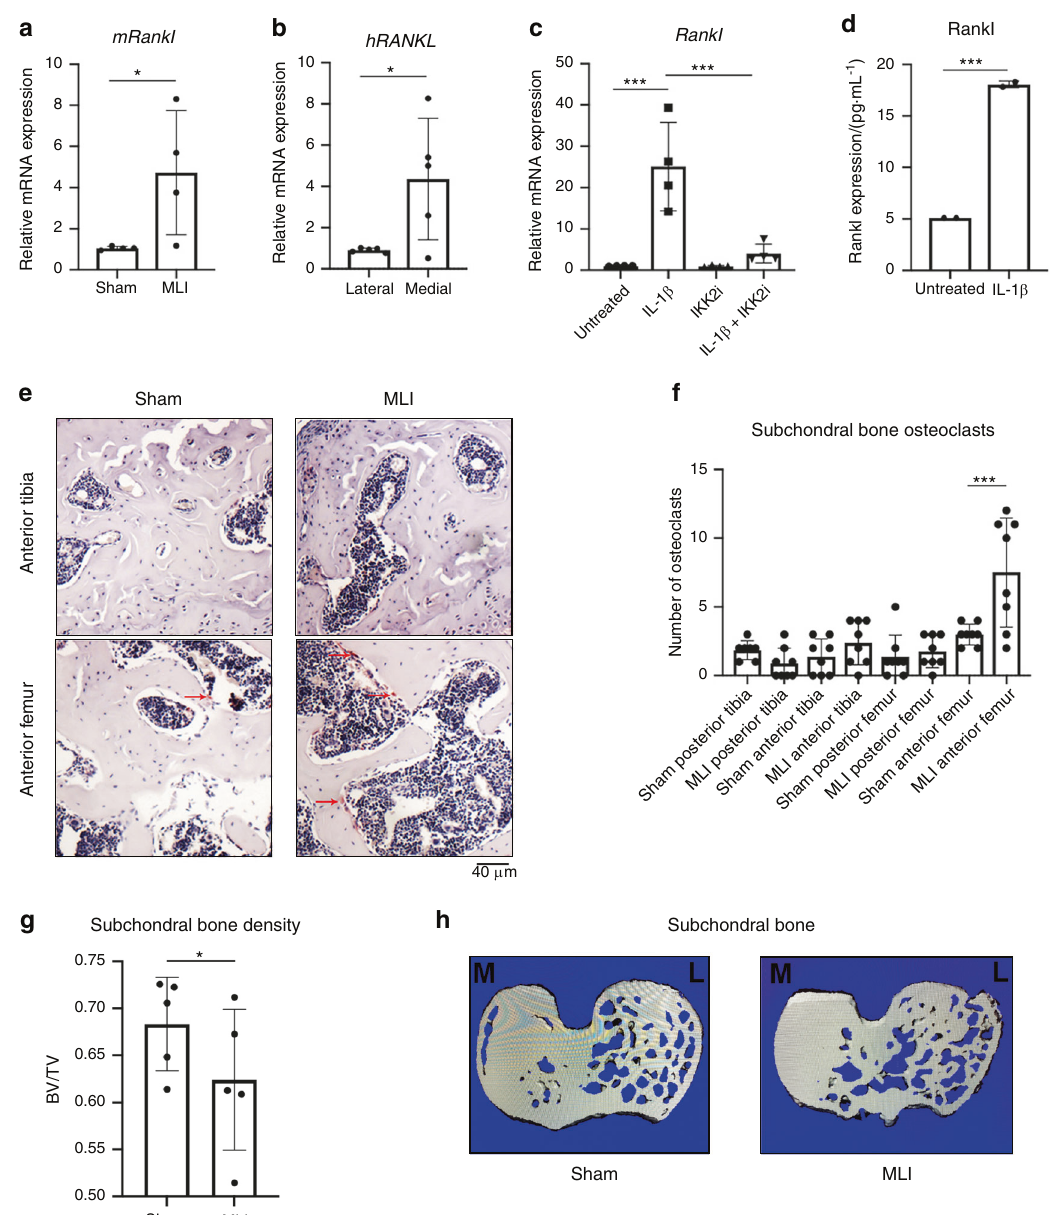
Fig. 1 Chondrocytes produce Rankl under in fl ammation. a MLI surgery was performed on 12-week-old mice. After 4 weeks, articular cartilage was isolated from sham and MLI knee joints and gene expression of Rankl was measured ( n = 4, * P = 0.050). Data are mean ± SEM. b Medial and lateral knee articular cartilage was isolated from patients undergoing TKA with medial compartment OA. Gene expression of human RANKL comparing more damaged medial cartilage to lateral cartilage ( n = 5, * P = 0.031). Data are mean ± SEM. c Primary chondrocytes were cultured with IL-1 β (10 ng·mL − 1 ) ± SC-514 (10 μ mol·L − 1 ) for 24 h. Rankl gene expression was measured (Untreated vs IL-1 β *** P = 0.000 2, IL-1 β vs IL-1 β + IKK2i *** P = 0.000 7), with data representing mean ± SEM of n = 4 independent experiments. d Rankl protein expression in IL-1 β treated (24 h) chondrocytes. Data are mean ± SD for n = 2 representative replicates (*** P = 0.003 3). e Two weeks post MLI, knee joints were fi xed and sectioned for TRAP staining to identify osteoclasts in the subchondral region (arrows). f TRAP positive cells were counted in anterior and posterior compartments of femur and tibia in MLI and Sham joints ( n = 8). (Sham Anterior Femur vs MLI Anterior Femur *** P = 0.002). Bars represent mean ± S.D. g MLI and sham surgeries were performed on right and left mouse knees, respectively. After 2 weeks, mice were sacri fi ced and joints were harvested and fi xed. Bone volume/total volume of subchondral region was measured by uCT in same region of each mouse tibia ( n = 5 mice) (* P = 0.036 5). h Representative image of subchondral slice from sham and MLI mouse joints displaying decreased bone volume (M and L indicate medial and lateral condyle,